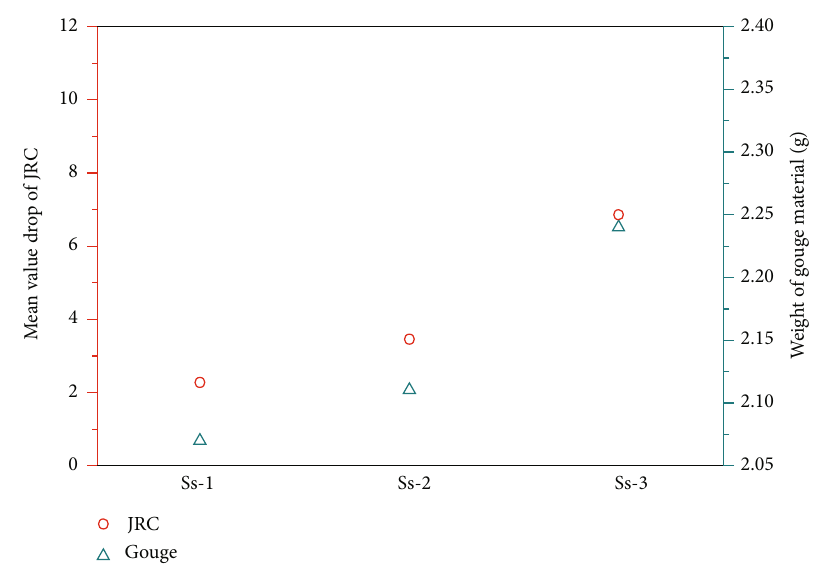
Figure 15: Mean value drop of JRC and weights of gouge material after testing under static stress.